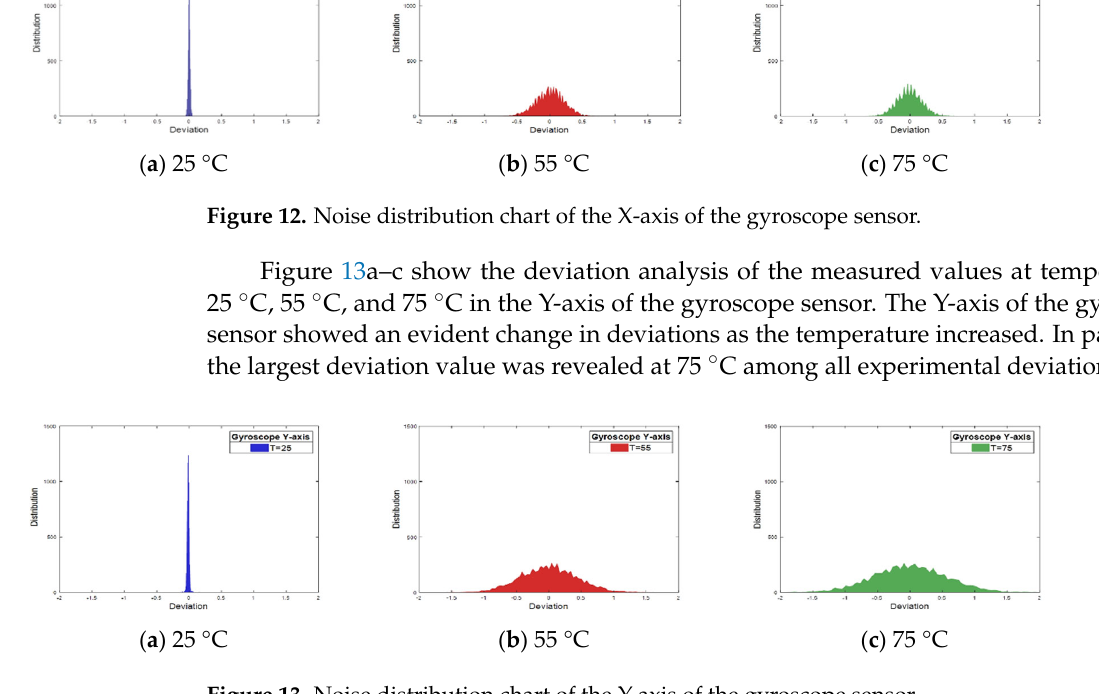
Figure 13. Noise distribution chart of the Y ‐ axis of the gyroscope sensor. Figures 14a–c show the deviation analysis of the measured values at temperatures 25 °C, 55 °C, and 75 °C in the Z ‐ axis of the gyroscope sensor. The Z ‐ axis of the gyroscope sensor showed a relatively stable result of deviation change by temperature compared to other axes, and the range of the deviations was the largest at 55 °C.